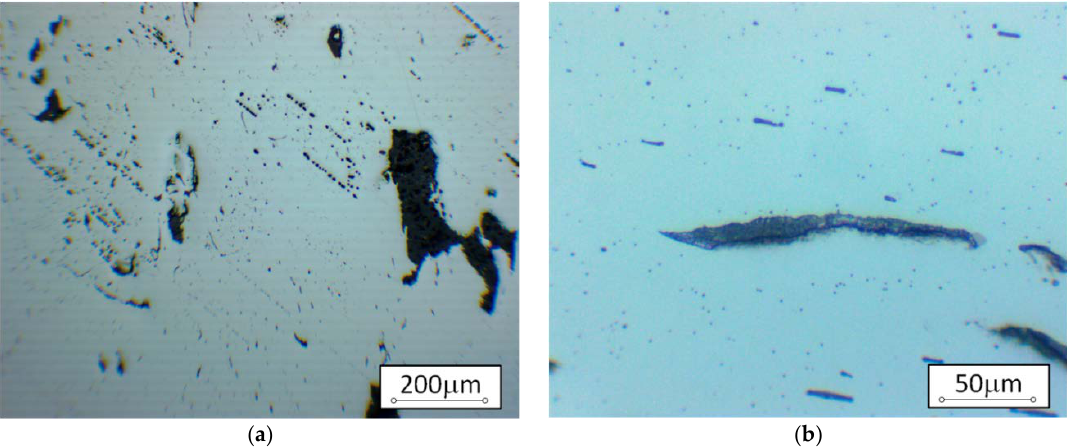
Figure 2. Typical non-metallic inclusions pattern for Eiffel puddle iron (non-etched state, light microscopy). ( a ) Typical non-metallic inclusions chains deformed in the rolling direction; ( b ) noticeable large non-metallic inclusions and slags; the size of the slags often exceeds 10 µm.